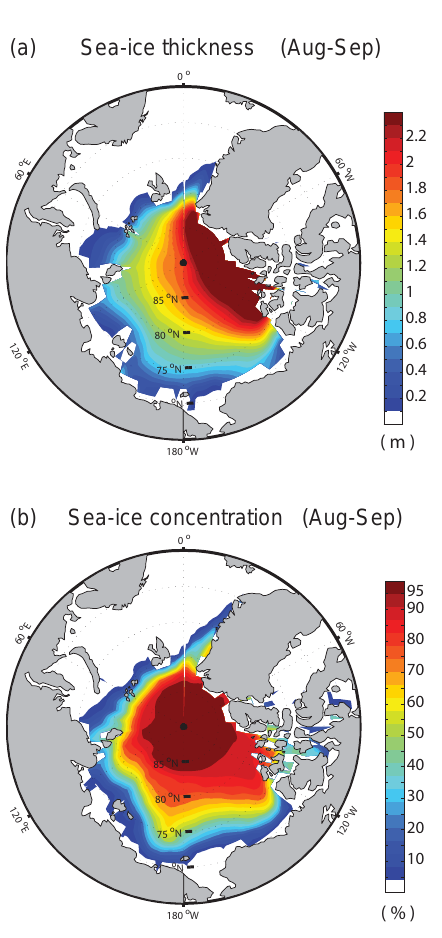
Figure 7. August–September climatological mean (a) sea ice thick- ness (m) and (b) sea ice concentration (%) between 1990 and 2012. Sea ice thickness is from PIOMAS and sea ice concentration data are from